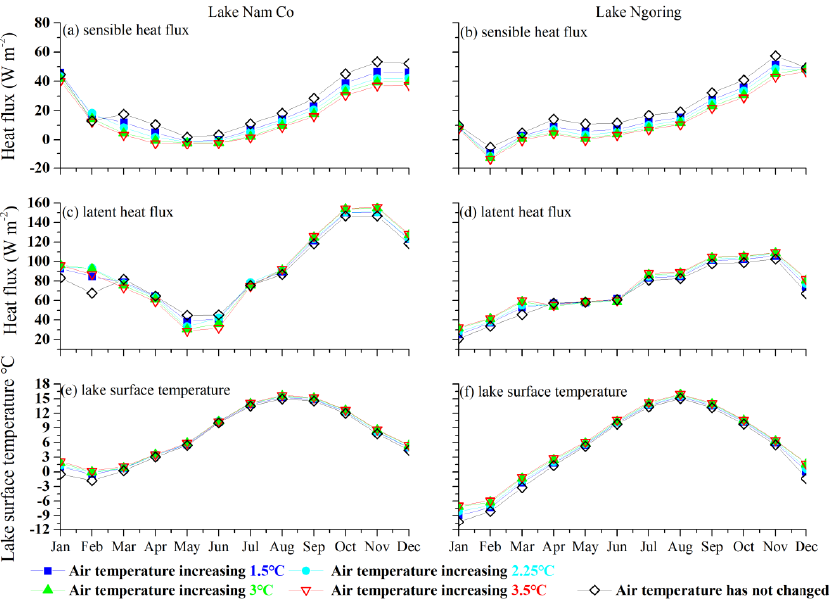
Figure 6. Seasonal variations in LST, H and LE after the air temperature has risen by 1.5, 2.25, 3 and 3.5 °C (averaged from January 2012 to December 2016) ( a, c, e ) at Lake Nam Co and ( b, d, f ) at Lake Ngoring. Figures 7 and 8 show the impact of different temperature increases on the seasonal changes in LE, H, LST, and lake mixed layer temperature (MLT). Here, we use the differ- ences between the different sensitivity tests (line in Figures 7 and 8) to analyze the influ- ence of different increase intervals on seasonal variations in the four variables. The differ- ences before and after the frozen period fluctuate significantly. The variability in the sen- sitivities for the four variables in the ice-free period is roughly the same at Lake Ngoring and at Nam Co, but the magnitude of the sensitivities is small. Since the frozen period is longer at Lake Ngoring, we can see differences between the variations in the sensitivities at the two lakes during the frozen period. In the middle of the frozen period, there is a relatively regular one-month (February) change in LST, LE and H with increasing air tem- perature at Lake Ngoring, and we do not see this at Nam Co. The thicker ice at Lake Ngor- ing means that the MLT is unaffected by the increase in air temperature for the three months after freeze-up. However, the MLT at Lake Nam Co changes significantly once the air temperature rises beyond 2.75 °C. At both lakes, there is a clear difference between the simulations with unchanged air temperature, and the simulations when the air tem- perature has been increased by 1.5 °C, shown with a black line in Figures 7 and 8. The next obvious difference is between the simulations calculated with temperature increases of 2.75 °C and 3.00 °C at Lake Nam Co, shown with blue line in Figures 7 and 8 (2.25 °C and 2.50 °C at Lake Ngoring, shown with a red line in Figures 7 and 8).